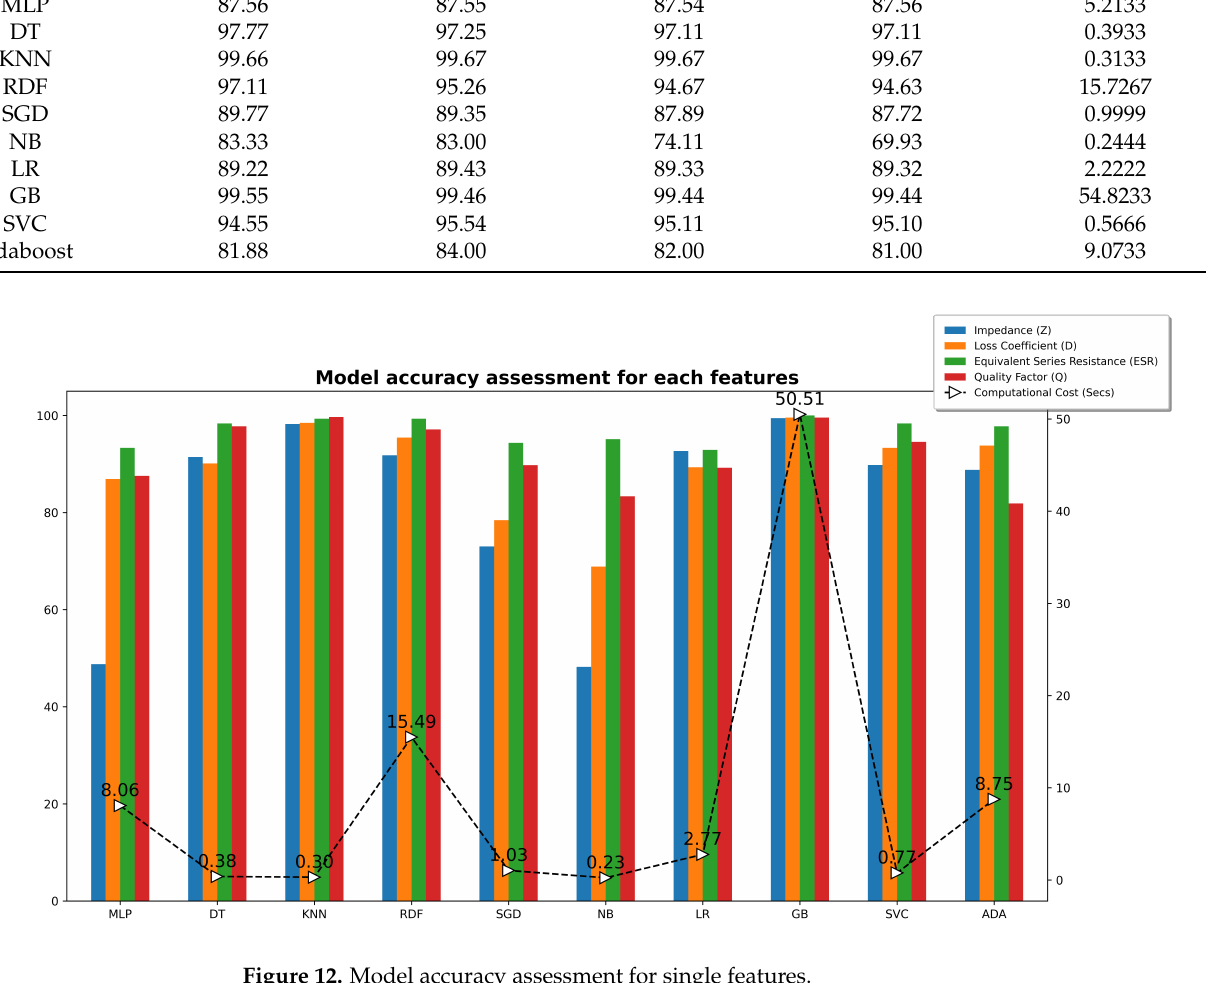
Figure 12. Model accuracy assessment for single